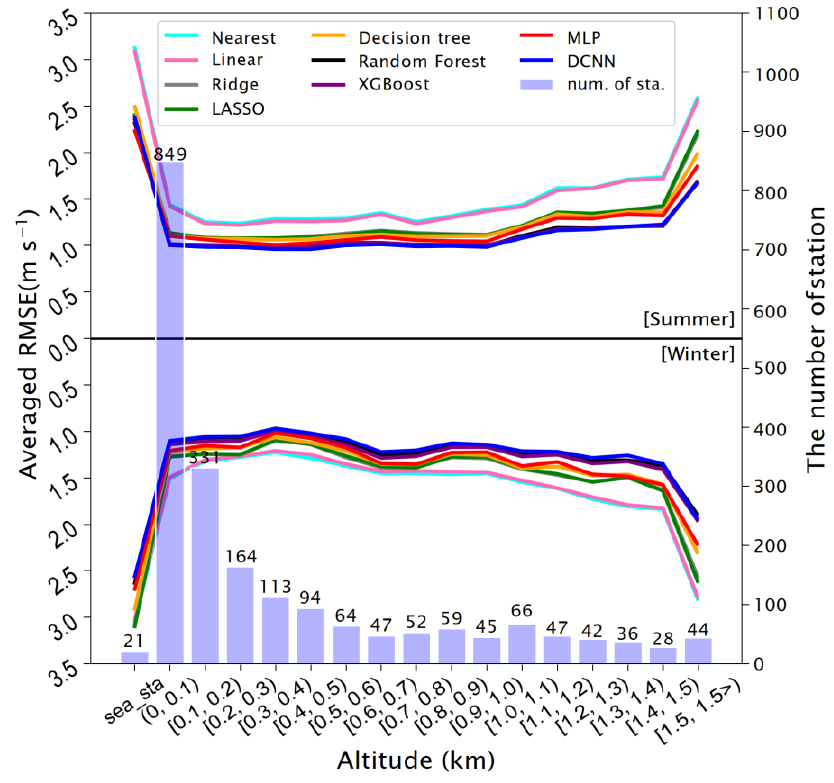
Figure 10. Comparison of errors in estimated wind speed at sites at different altitudes. Bars indicate the number of sites at each altitude interval, and lines give the average RMSE of winter and summer wind speeds estimated using each method at the corresponding altitude.